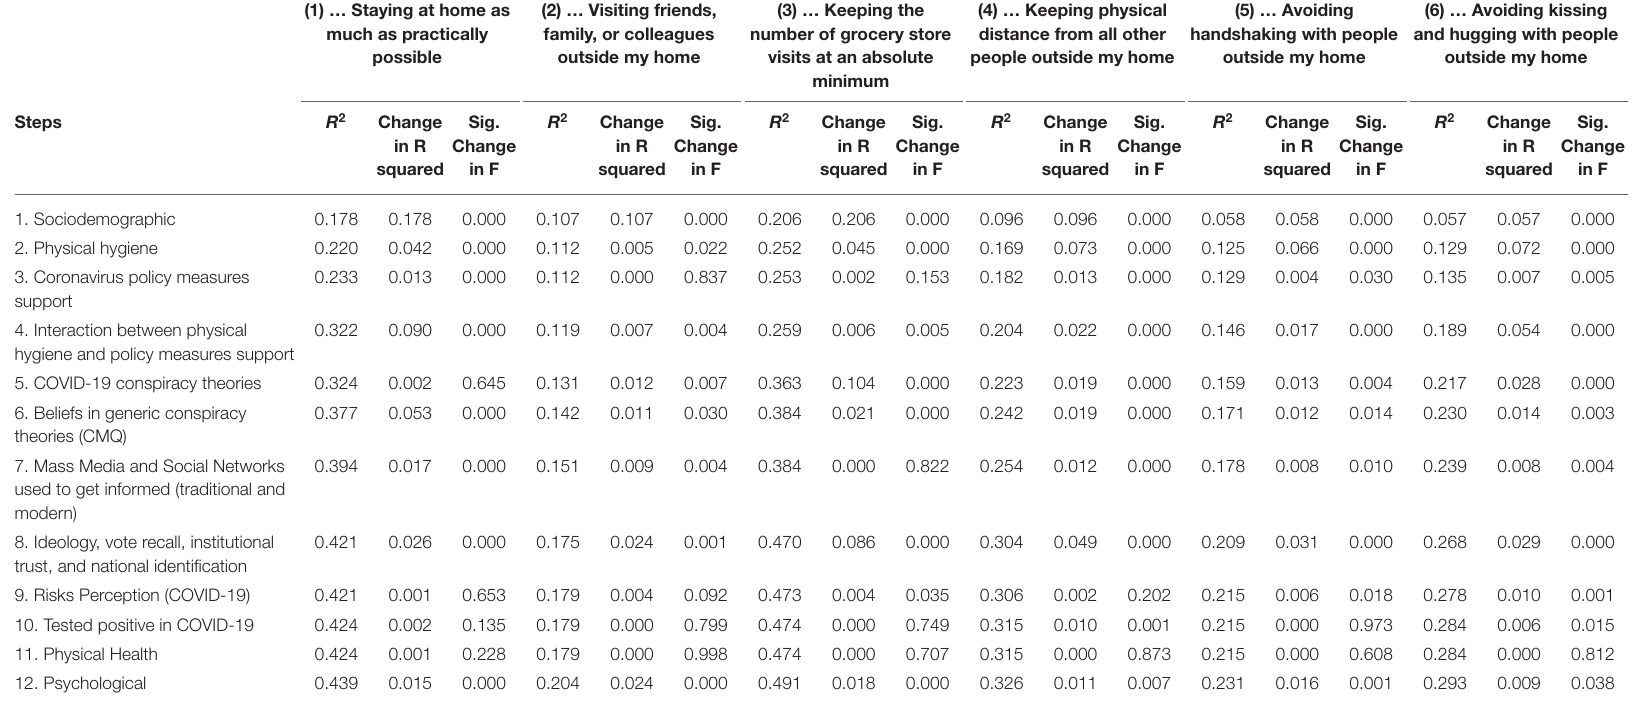
TABLE 2 | Hierarchical regression models and statistics of